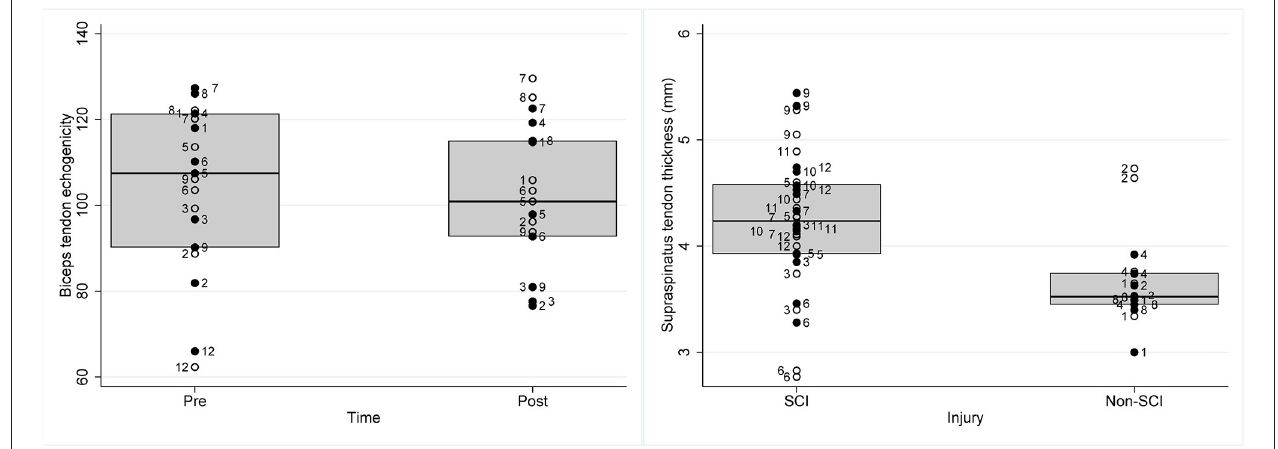
FIGURE 2 | Box plots representing raw data of individual wheelchair rugby athletes of (left) biceps tendon echogenicity pre and post a graded exercise test to exhaustion and (right) supraspinatus tendon thickness (mm) in athletes with SCI and non-SCI. Full circles with participant ID on the right side of the circle represents data of the dominant shoulder of the respective athlete, the empty circles with the participant ID on the left side of the circle represents data of the non-dominant shoulder of the respective